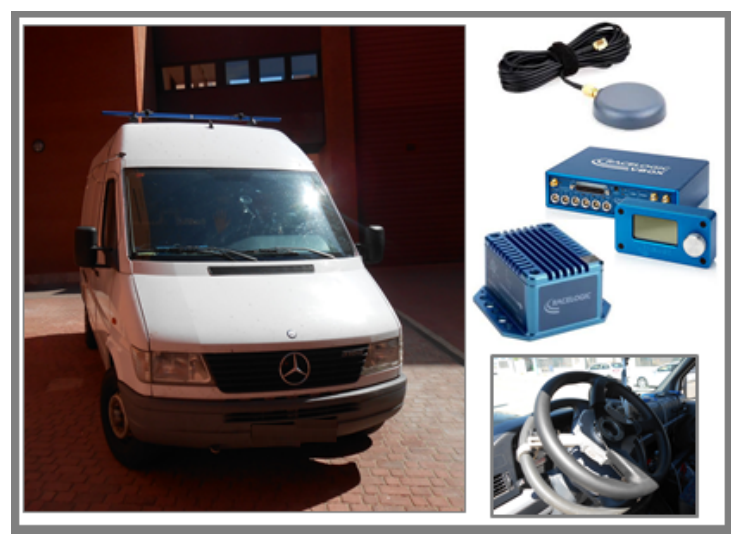
Figure 6. Real Mercedes Sprinter van and instruments setup.